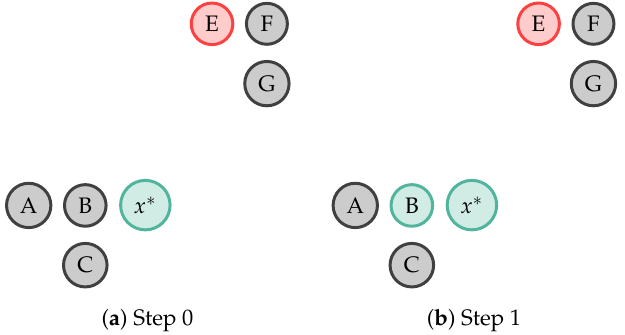
Figure 4. Example of 1-Nearest Neighbour (NN) label propagation, in which the sample x ∗ propagates its label (in this example represented by the colour green) to its 1-NN, the sample B . Each circle represents a sample whose colours, green and red, represent two different classes. The samples in grey denote unlabelled